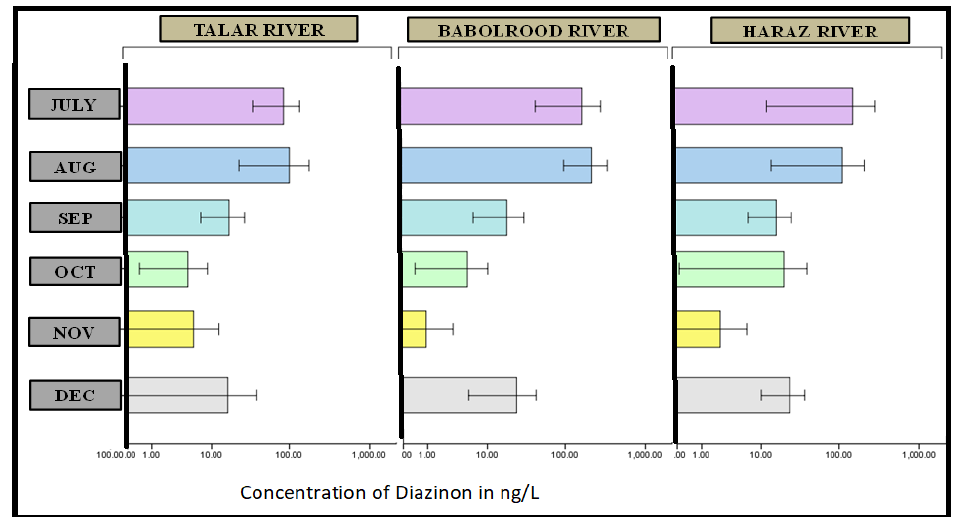
Figure 2. Monthly distribution of diazinon in the Talar, Babolrood and Haraz rivers.